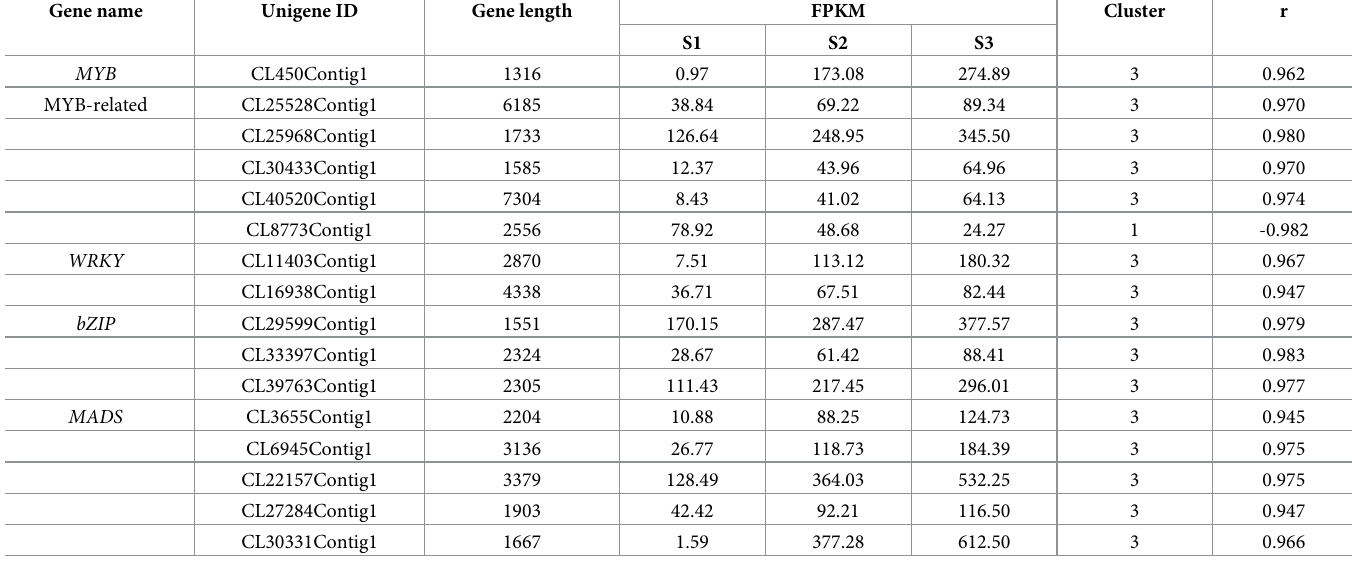
Table 3. Expression profiles, clusters distribution, and correlation analysis of 16 TFs related to anthocyanin biosynthesis in the different fruit maturation stages of L . ruthenicum . The table shows the TFs that were significantly correlated with five or more structural genes. “r” represents the Pearson correlation coefficient between TFs and anthocyanin contents in different developmental